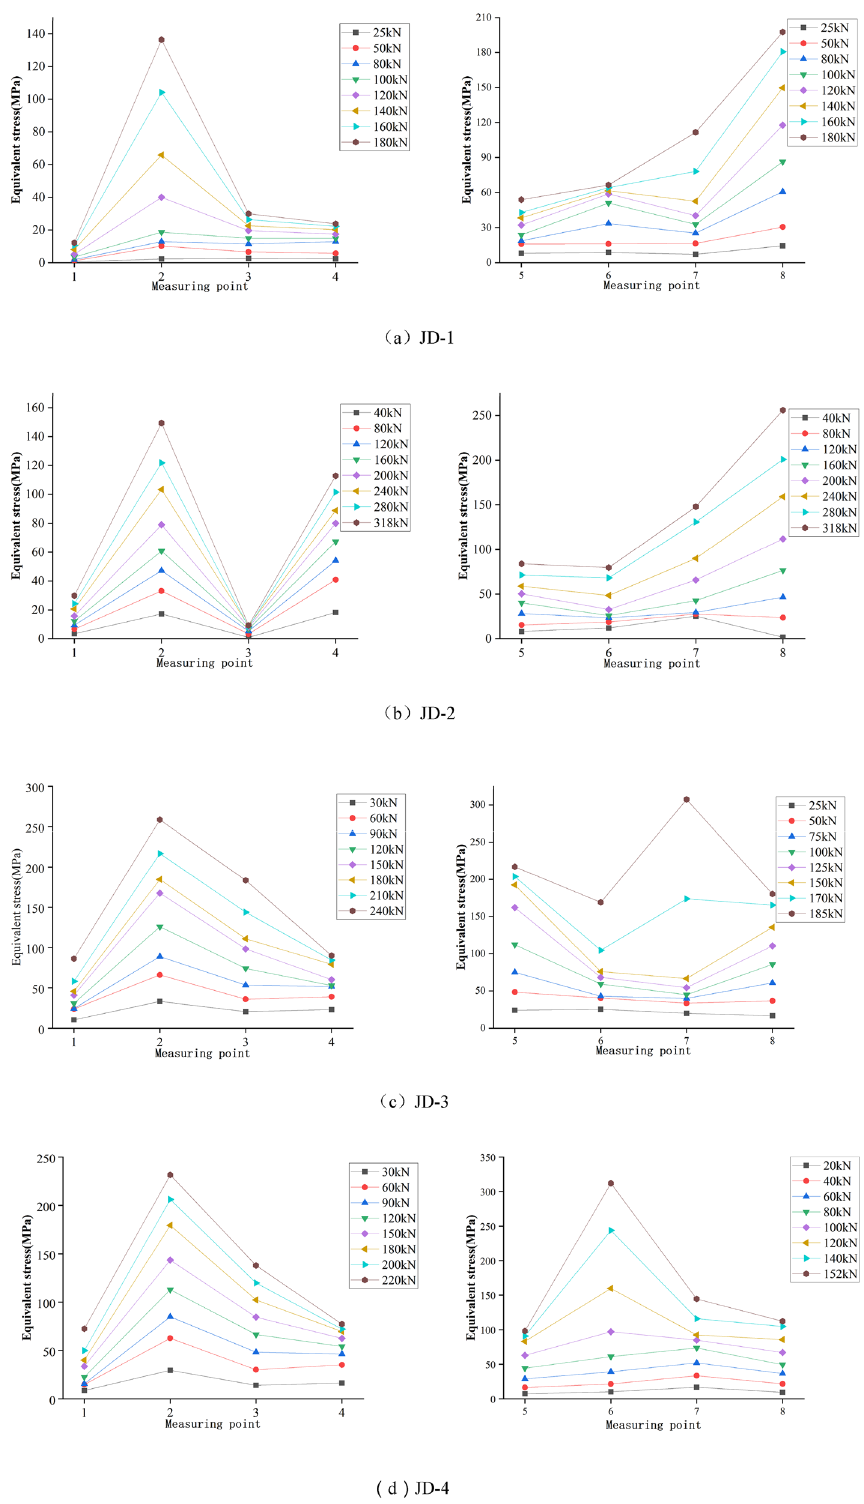
Figure 10. Equivalent stress curve of the ball table at compression zone and tension